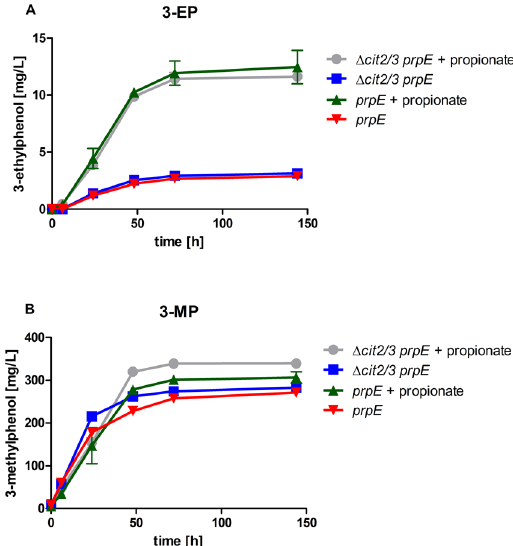
Figure 3. Influence of overexpression of a propionyl-CoA synthetase on 3-ethylphenol ( A ) and 3-methylphenol ( B ) formation with and without supplementation of external propionate. Yeast strains CEN.PK2-1C expressing the 3-methylphenol pathway ( Ppopt MSAS , opt npgA and opt patG 14 ) and additionally the propionyl-CoA synthase opt prpE , with or without the Δ cit2 Δ cit3 double deletion (strains JHY185 and JHY218, respectively), were inoculated at an OD of 5 and cultivated for 144 h in KP i buffered YPD medium (pH 6.5) with or without supplementation of 10 mM propionate. Culture supernatants were analysed via HPLC for 3-alkylphenol production. Error bars represent standard deviations of biological